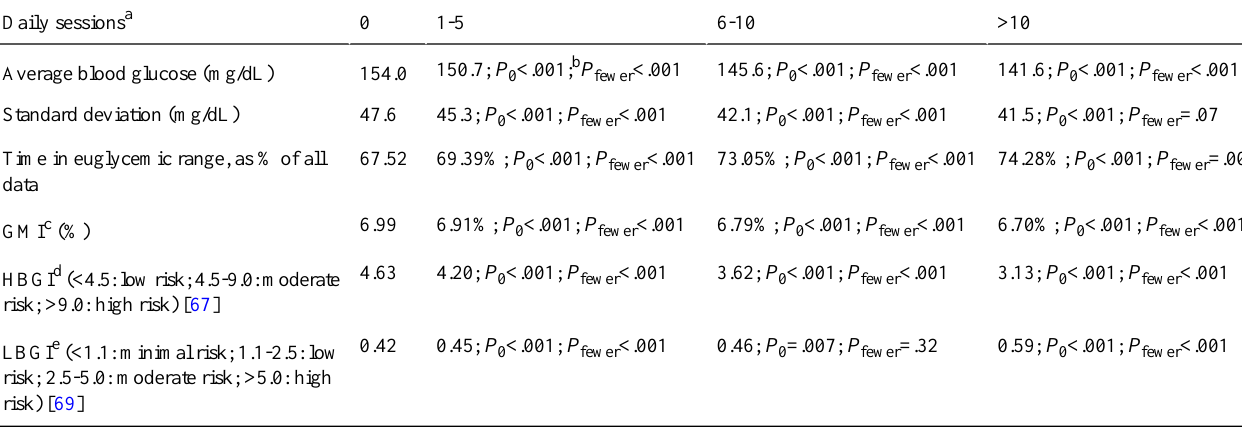
Table 2. Various metrics of blood glucose control as a function of frequency of daily Diabits